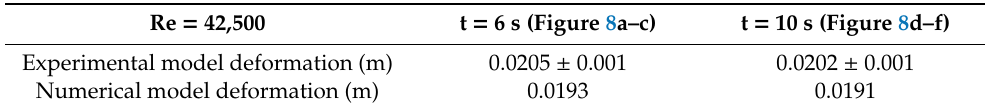
Figure 8. Comparison of total deformation of T-shaped flexible beam for Re = 42,500 and t = 6 s. ( a ) Experiment (high-speed camera system (HSC)), ( b ) experiment (HSC) with image track program, and ( c ) numerical (CFD). Comparison of total deformation of T-shaped flexible beam for Re = 42,500 and t = 10 s. ( d ) Experiment (HSC), ( e ) experiment (HSC) with image track program, and ( f ) numerical (CFD). Table 4. Comparison of maximum deformation of T-shaped flexible beam for Re = 42,500, t = 6 s, and t = 10 s.